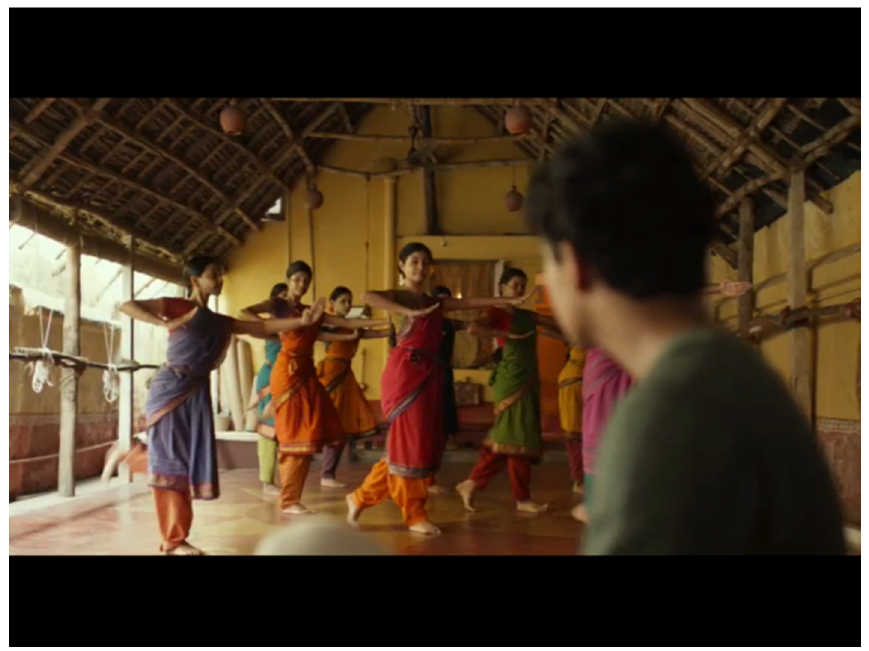
Figure 5. Bharatanatyam dancing, visually echoing scenes from Phantom India (1960).